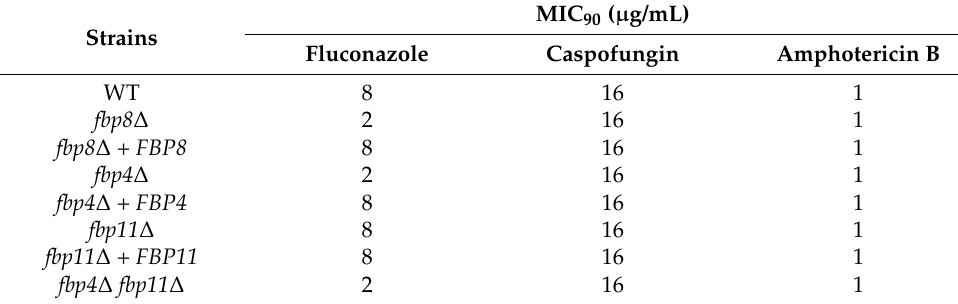
Table 2. In vitro susceptibility of strains to antifungal